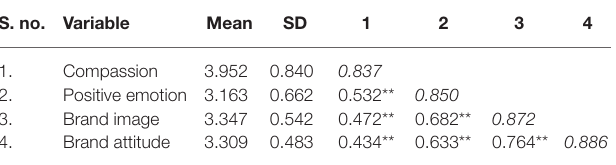
TABLE 3 | Descriptive statistics.